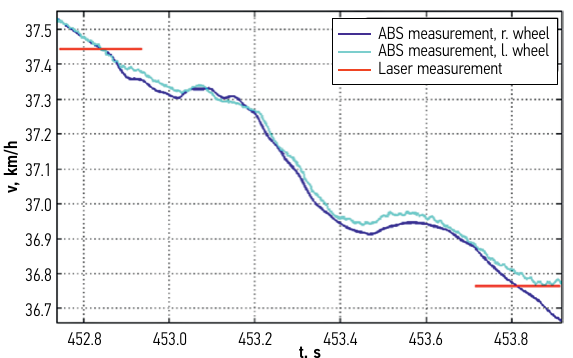
ABS measurement, r. wheel ABS measurement, l. wheel Laser measurement